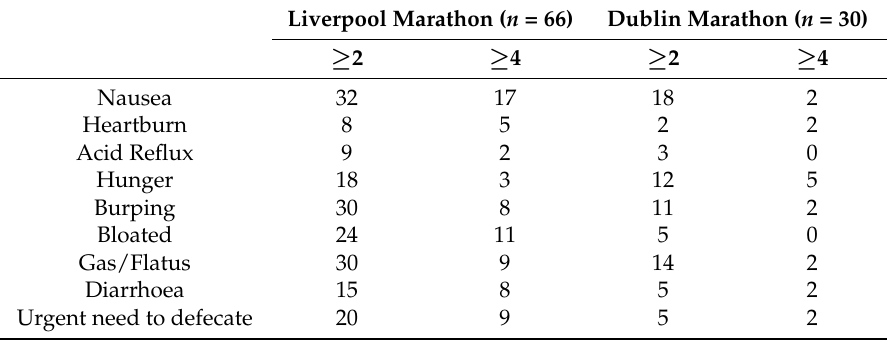
Table 4. Prevalence of individual symptom scores ( ≥ 2) and moderate ( ≥ 4) symptoms. Data are percentage of participants in each